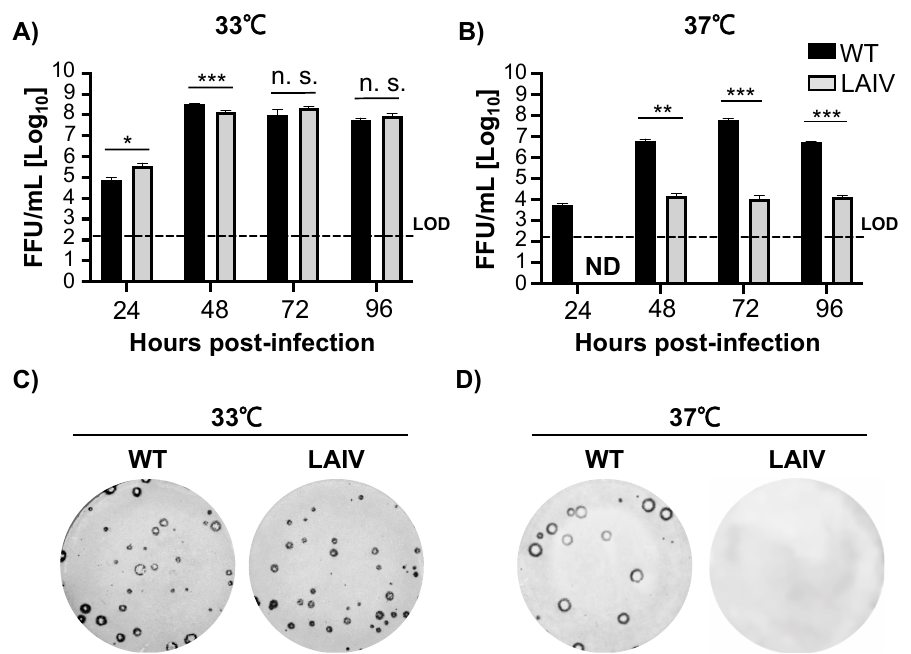
Figure 3. B/Brisbane/60/2008 WT and MDV LAIV replication at different temperatures. ( A , B ) Viral growth kinetics: MDCK cells were infected (MOI of 0.01 FFU/cell) with either B/Brisbane/60/2008 WT (black) or MDV LAIV (grey) and incubated at 33 ° C ( A ) or 37 ° C ( B ). Tissue culture supernatants from infected cells were collected at 24, 48, 72 and 96 h post-infection and virus titers were determined by immunofocus assay (FFU/mL) with a mouse monoclonal antibody against IBV NP. Dotted lines indicate the LOD of the assay (200 FFU). ND = Not detected. Data is represented as the mean and SD. Student t test was performed to determine p values. *, p < 0.05; **, p < 0.01; ***, p < 0.001; n.s.: not significant. ( C , D ) Plaque assays: MDCK cells were infected with either B/Brisbane/60/2008 WT or MDV LAIV and after 1 h infection, cells were overlaid with media containing agar and incubated at 33 ° C ( C ) or 37 ° C ( D ). At 72 h post-infection viral plaques were immunostained with an anti-IBV NP mouse monoclonal antibody.